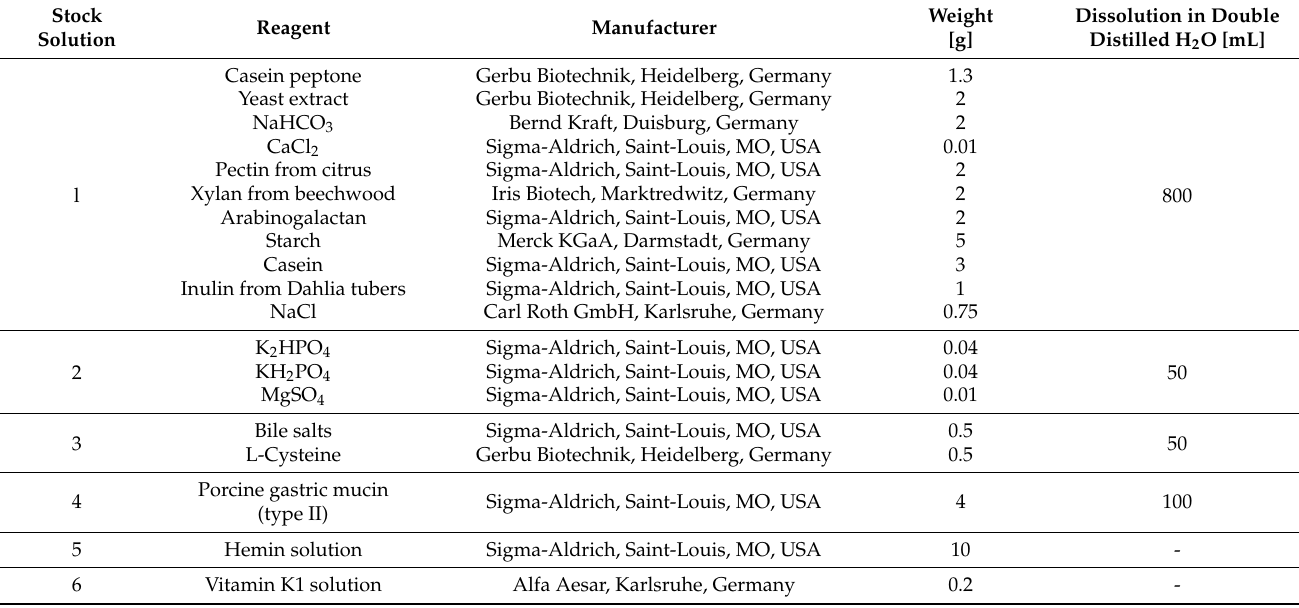
Table 1. Ingredients for preparation of 1000 mL Continuous Flow Fermentation Medium adapted according to Macfarlane and Gibson